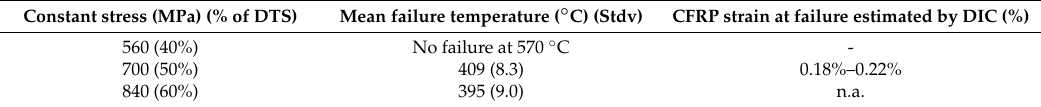
Table 2. Results of transient thermal tensile tests of prestressed UHM tendons. n.a. means not applicable.